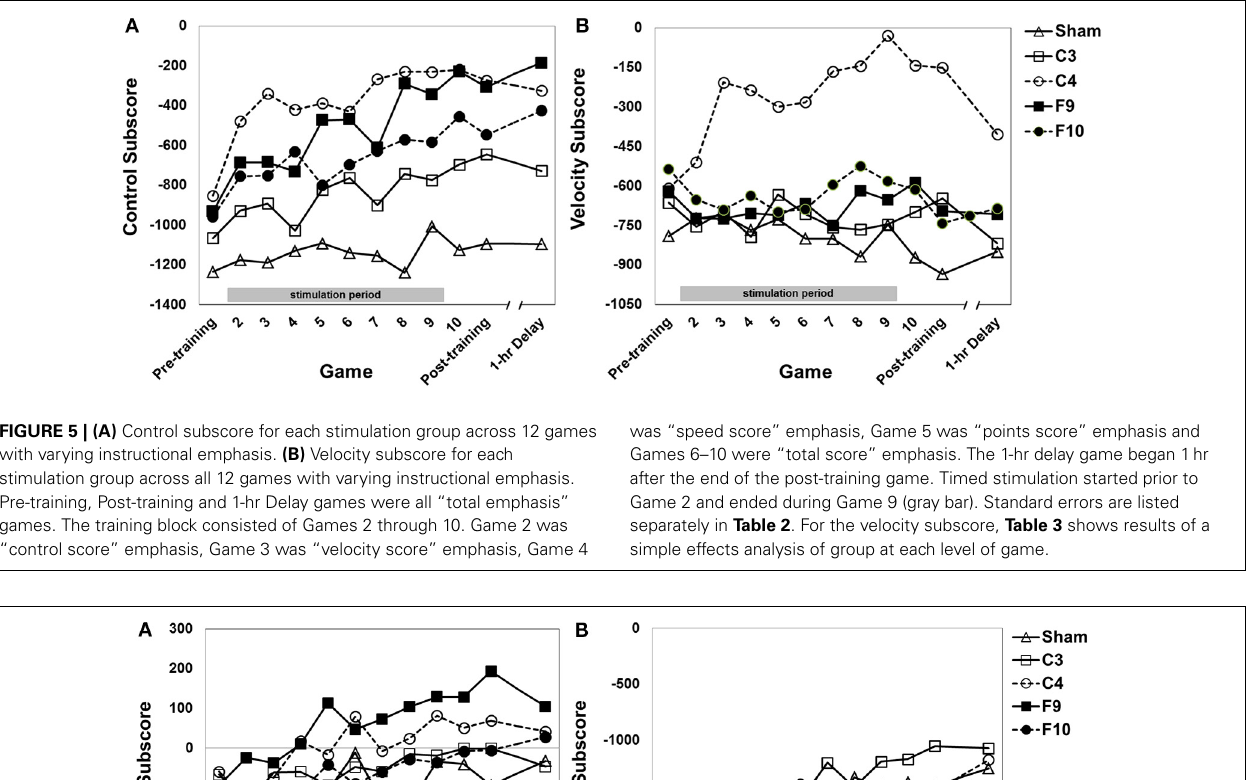
“velocity score” emphasis, Game 4 was “speed score” emphasis, Game 5 was “points score” emphasis and Games 6–10 were “total score” emphasis. The 1-hr delay game began 1hour after the end of the post-training game. Timed stimulation started prior to Game 2 and ended during Game 9 (gray bar). Standard errors are listed separately in Table 2 .